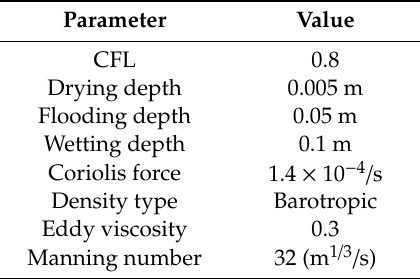
Table 1. Solution parameters values.